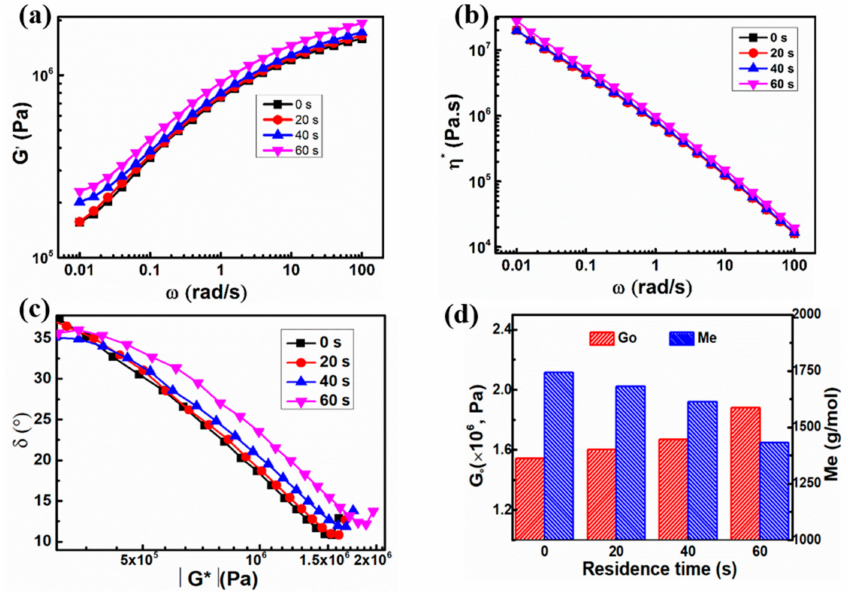
Figure 4. Frequency sweep of the UHMWPE samples prepared under the elongational flow for 0 s to 60 s residence time: ( a ) storage modulus; ( b ) complex viscosity; ( c ) van Gurp-Palmen (vGP) plot; ( d ) G 0 and M e N